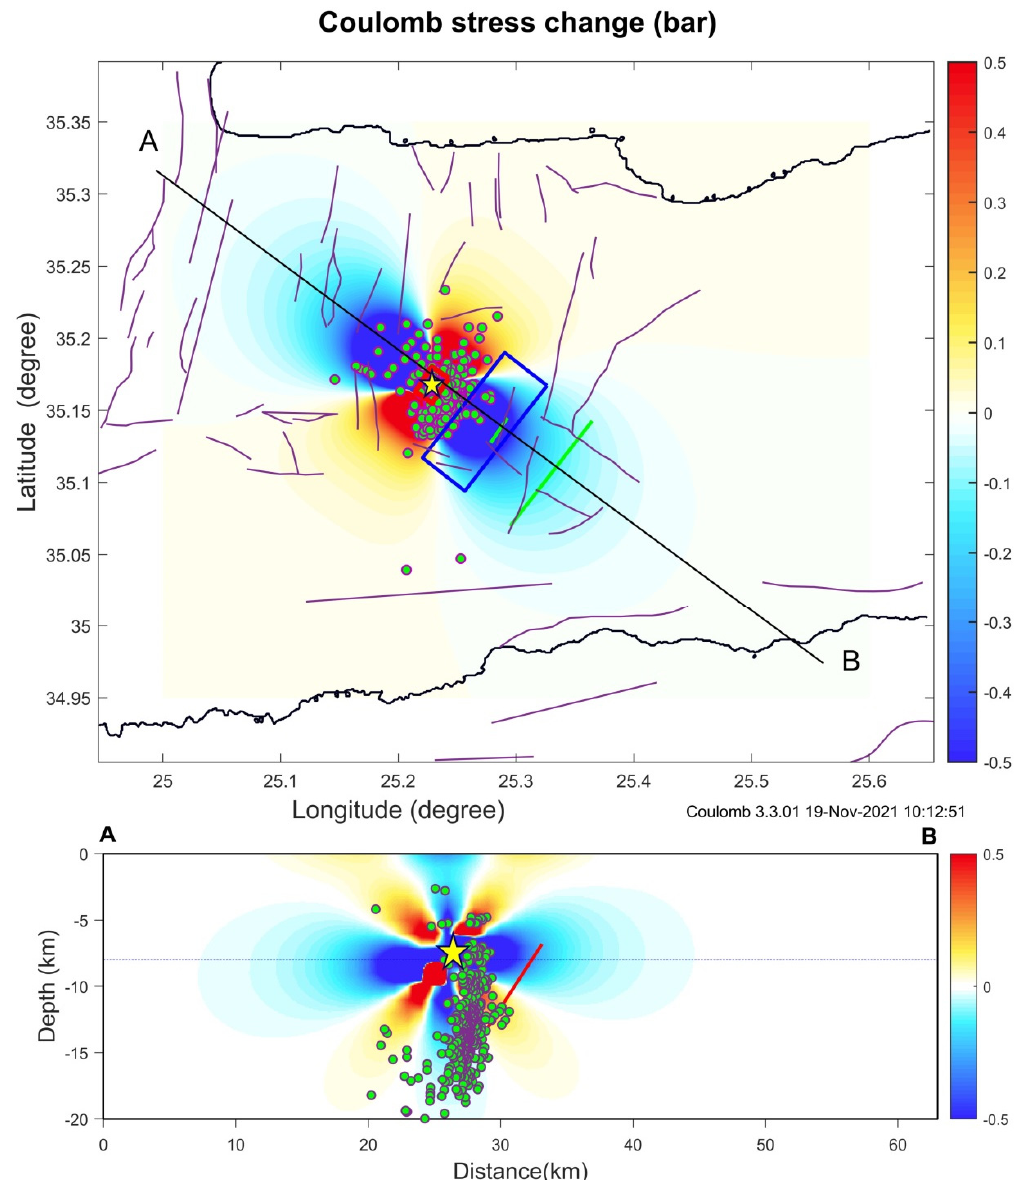
Figure 12. ( Up ) Coulomb stress changes distribution due to Mw = 4.9 event (yellow star) at centroid depth of 8.0 km. The red rectangle indicates the fault model for the kinematics of Mw = 4.9, while the blue one is the projection of the fault model of Mw = 6.0 main shock (listed in Table 3). ( Down ) Coulomb stress changes along the vertical cross-section AB. The green circles are the relocated hypocenters of the aftershocks which occurred after the Mw = 4.9 and before the major earthquake Mw = 6.0. The green lines show the surface projections of the two fault models.